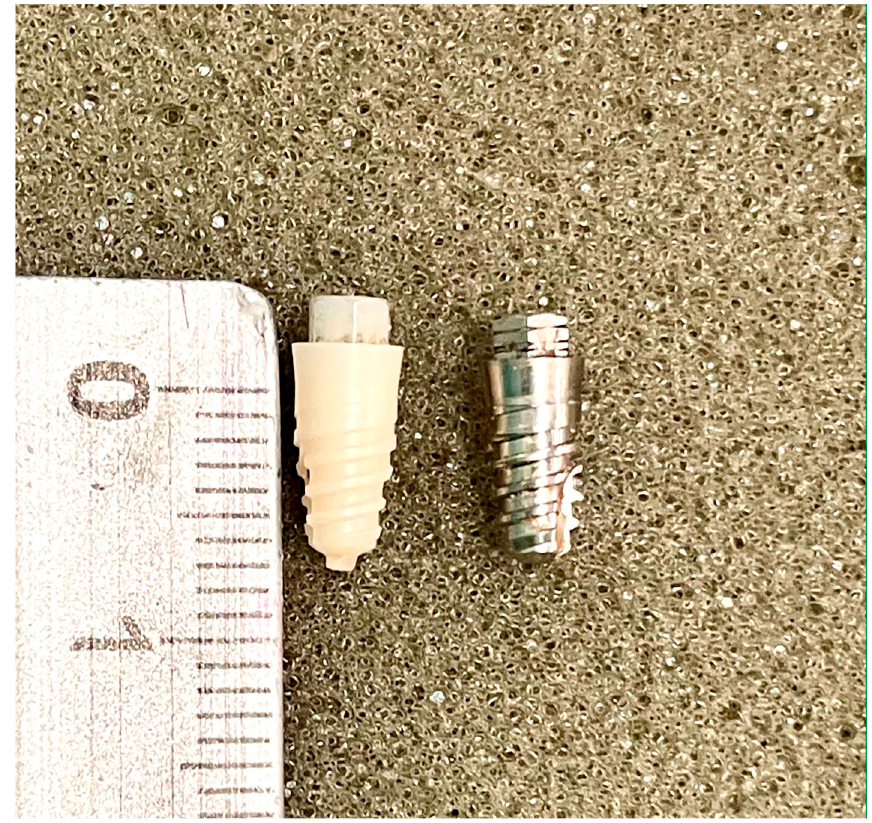
Figure 1. Klockner External Hex SK2 implants, Zr and Ti, both with 3.8*8 buffed surface (Soadco S.L., Escaldes Engordany, Andorra).